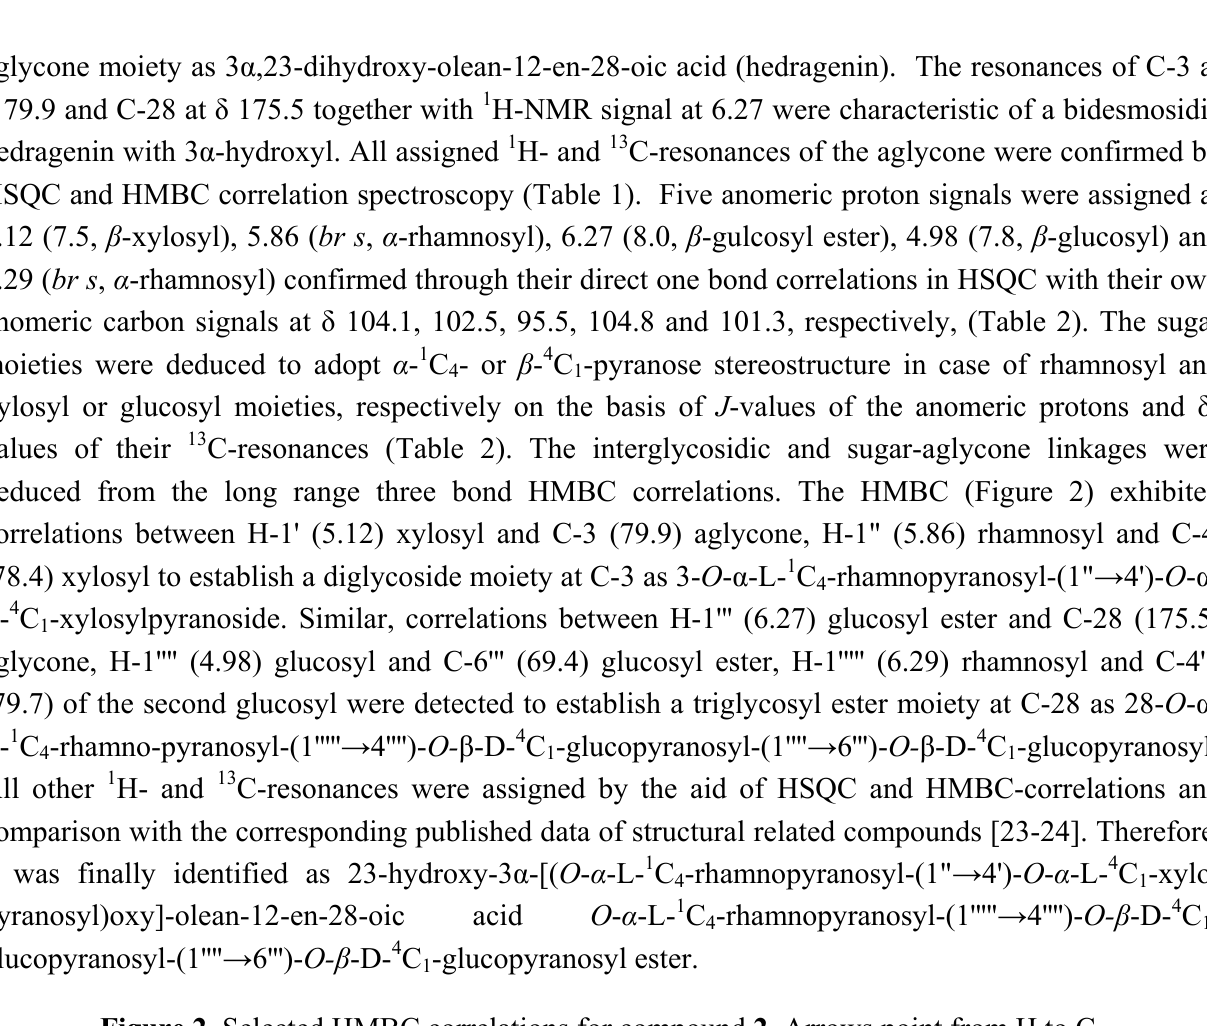
Figure 2. Selected HMBC correlations for compound 2 . Arrows point from H to